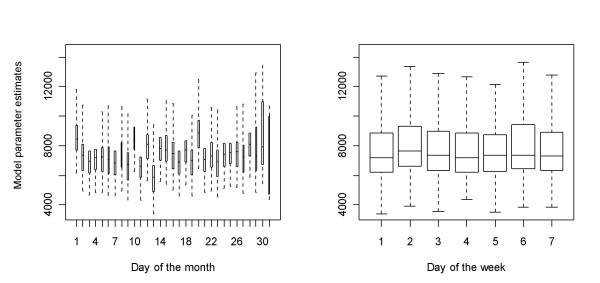
Box plots of the fitted model outputs for the generalised linear model for cattle births reported to BCMS over the period 1st Jan 2002 and 28th Feb 2005. (a) effect of day of the month (b) effect of day of the week (1- Sunday : 7-Saturday). Boxes incorporate the standard errors around the parameter estimate with error bars indicating the 95% confidence interval.